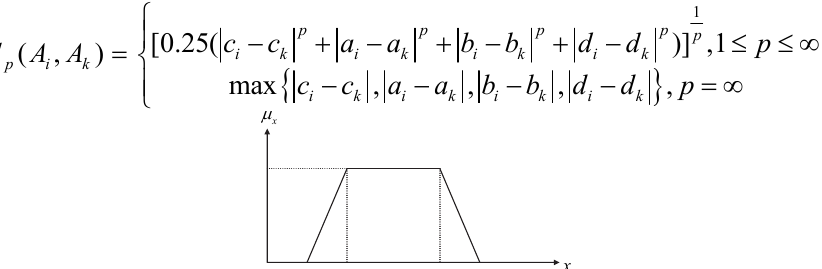
Fig. 1. Membership fumction of a trapezoidal fuzzy